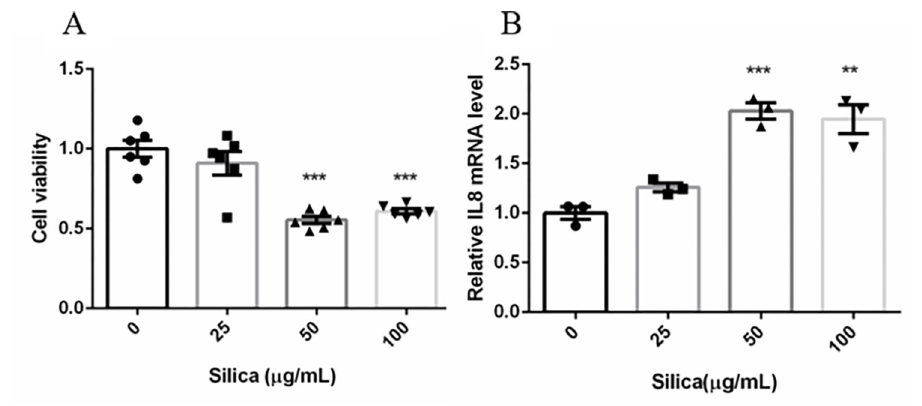
Fig 2. The influence of crystalline silica on BEAS-2B cells. (A). Cell viability in response to different concentrations of silica. (B). IL-8 mRNA expression in response to different concentrations of silica. Data are presented as the mean ± SEM; *** , p < 0.001; ** , p < 0.01.